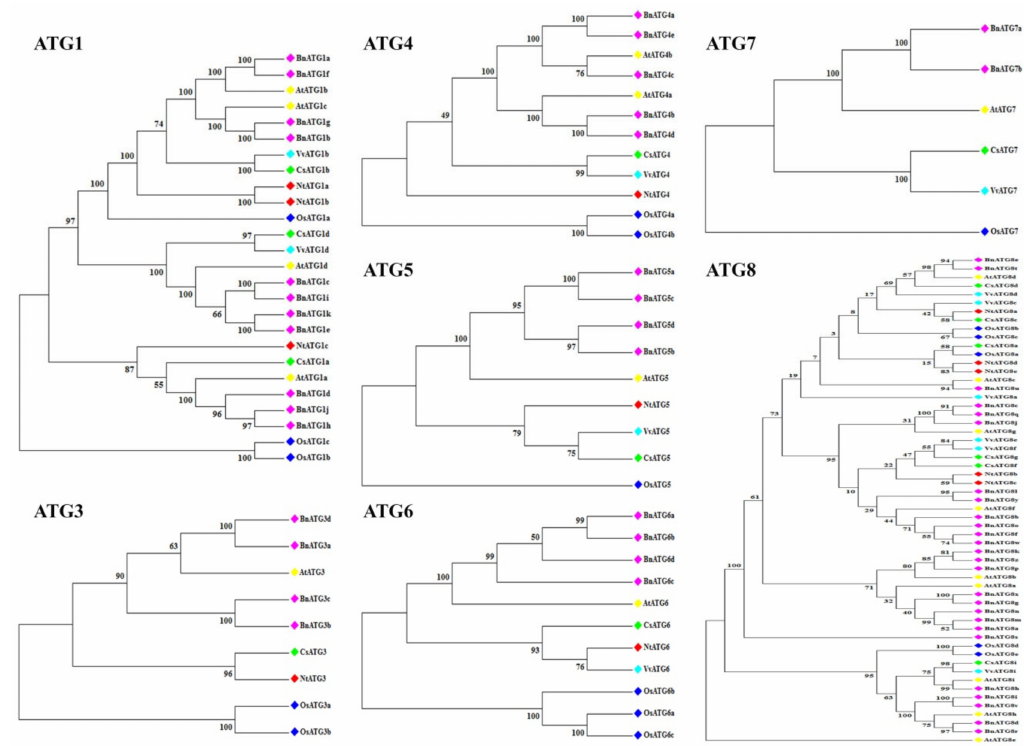
Figure 1. Phylogenetic relationships of BnATG1-BnATG8 proteins from Brassica napus (Bn), Arabidopsis thaliana (At), Citrus sinensis (Cs), Oryza sativa (Os), Vitis vinifera (Vv), and Nicotiana tabacum (Nt). The tree was constructed using MEGA 7 by the neighbor-joining (NJ) method with 1000 bootstraps. The names with pink rhombus are B. napus